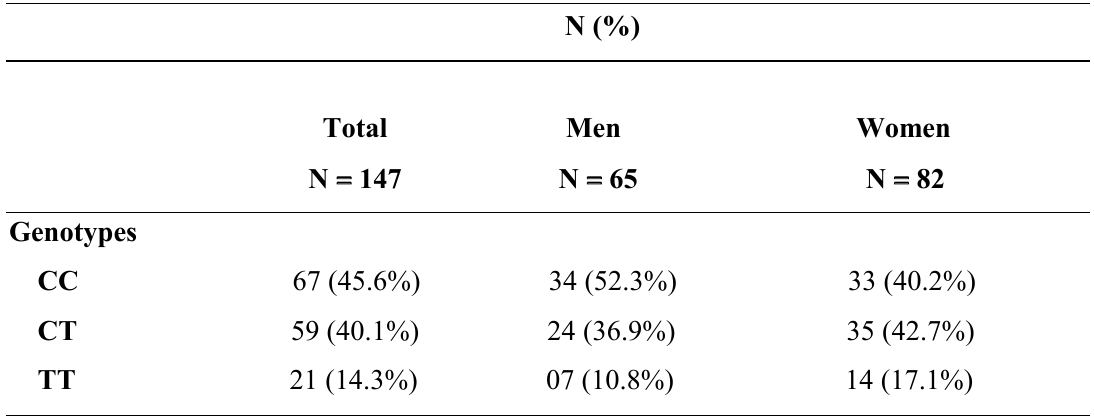
Table 2. Genotype distribution of the C677T polymorphism in the MTHFR gene by gender in the study group